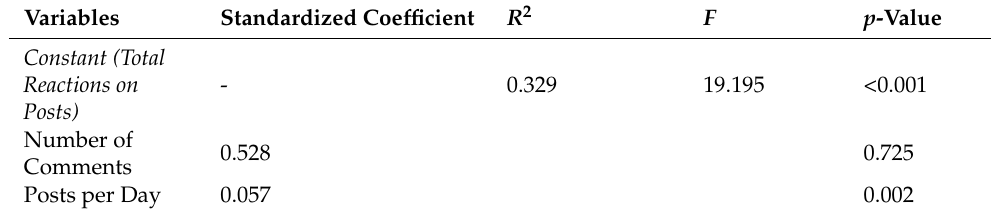
Table 5. Regression analysis for